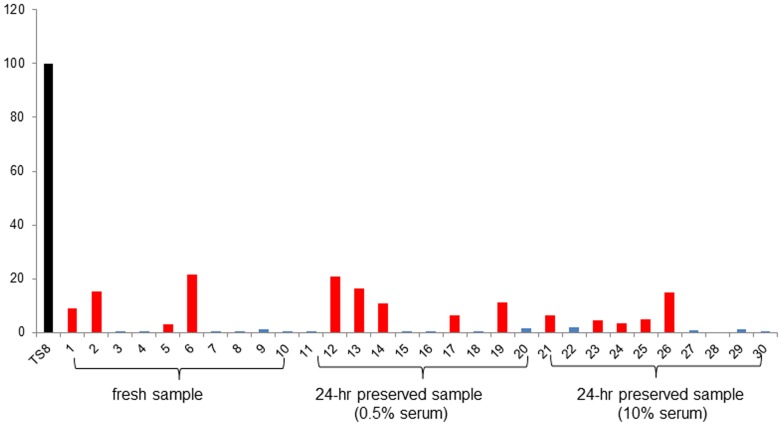
Telomerase activity in fresh USCs and 24-hr preserved USCs.Four of 10 fresh USCs, 5 of 10 preserved USCs (both preserved media with 0.5% and 10% FBS), respectively, showed significant telomerase activity (red bars). TS 8 were the positive control.